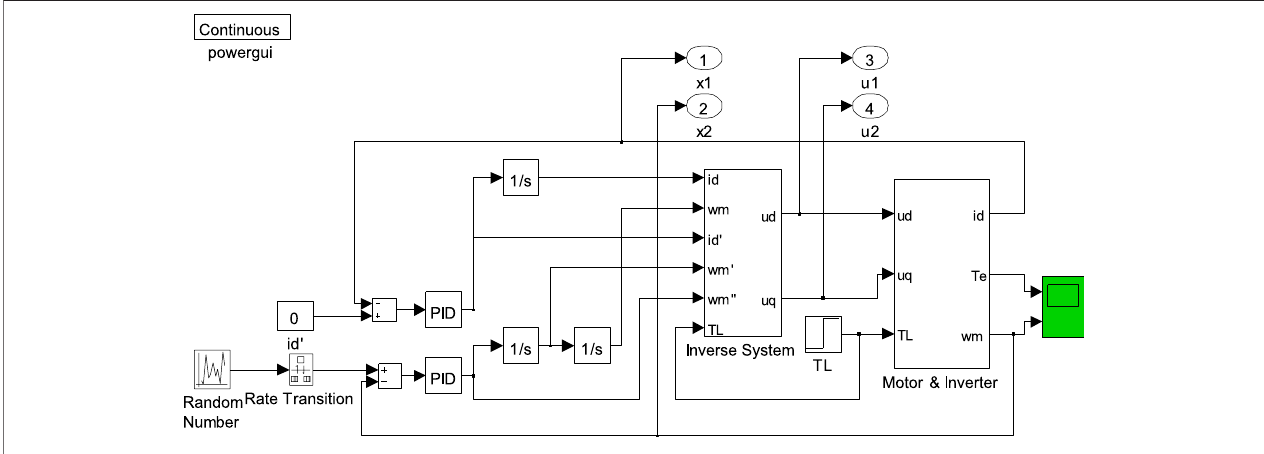
FIGURE 1 | PMSM inverse system sampling simulation diagram.